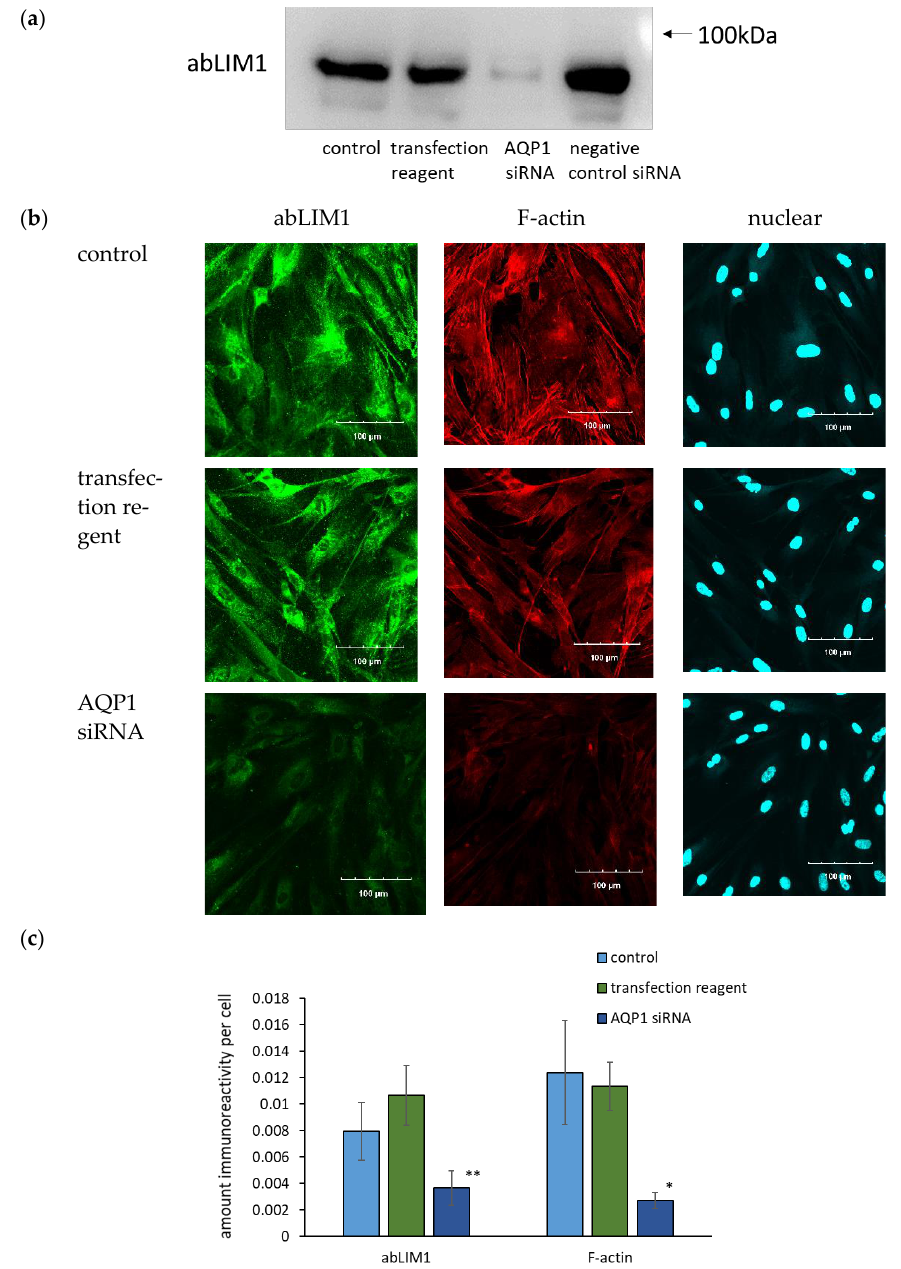
Figure 5. ( a ) Western blotting for abLIM1 in cultured human dermal fibroblasts following AQP1 depletion by AQP1 siRNA. ( b ) Antibody staining for the abLIM1 chain and F-actin in cultured human dermal fibroblasts after AQP1 depletion by AQP siRNA. ( c ) Image analysis of the amount of immunoreactivity per cell using ImageJ. *: p < 0.05 vs. the transfection reagent. **: p < 0.01 vs. the transfection reagent. The figure shows the means ± standard deviations ( n = 3).